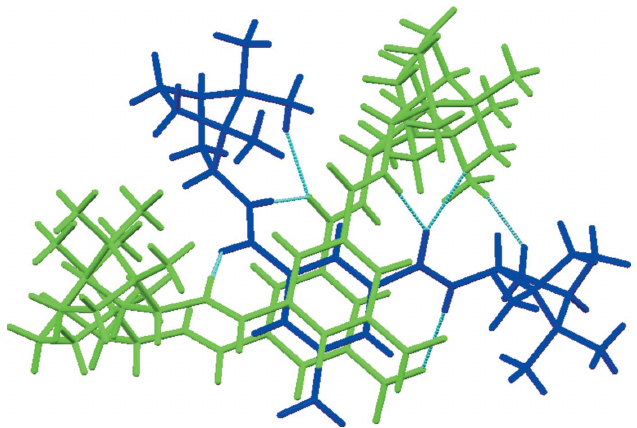
Figure 2 Detail of the extended structure showing [100] stacked layer formation of the C1 (green) and C30 (blue) molecules due to N—H (cid:2)(cid:2)(cid:2) O and C— H (cid:2)(cid:2)(cid:2) O hydrogen bonds